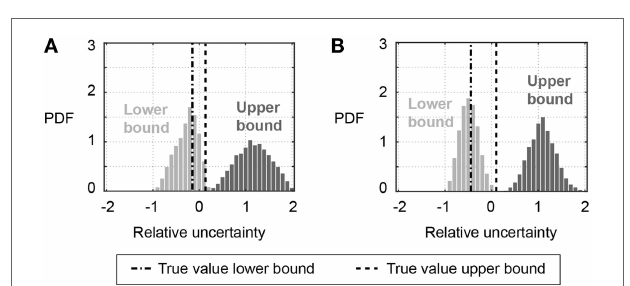
FIGURE 9 | Identification of parametrized bounds to the L 1 norm likelihood function implemented in modified Bayesian model updating (S 3,MBMU in Table 2 ). (A) Bounds to uniform likelihood function for initial frequency ( f ini ) and (B) bounds to uniform likelihood function for post-earthquake frequency ( f peq ).